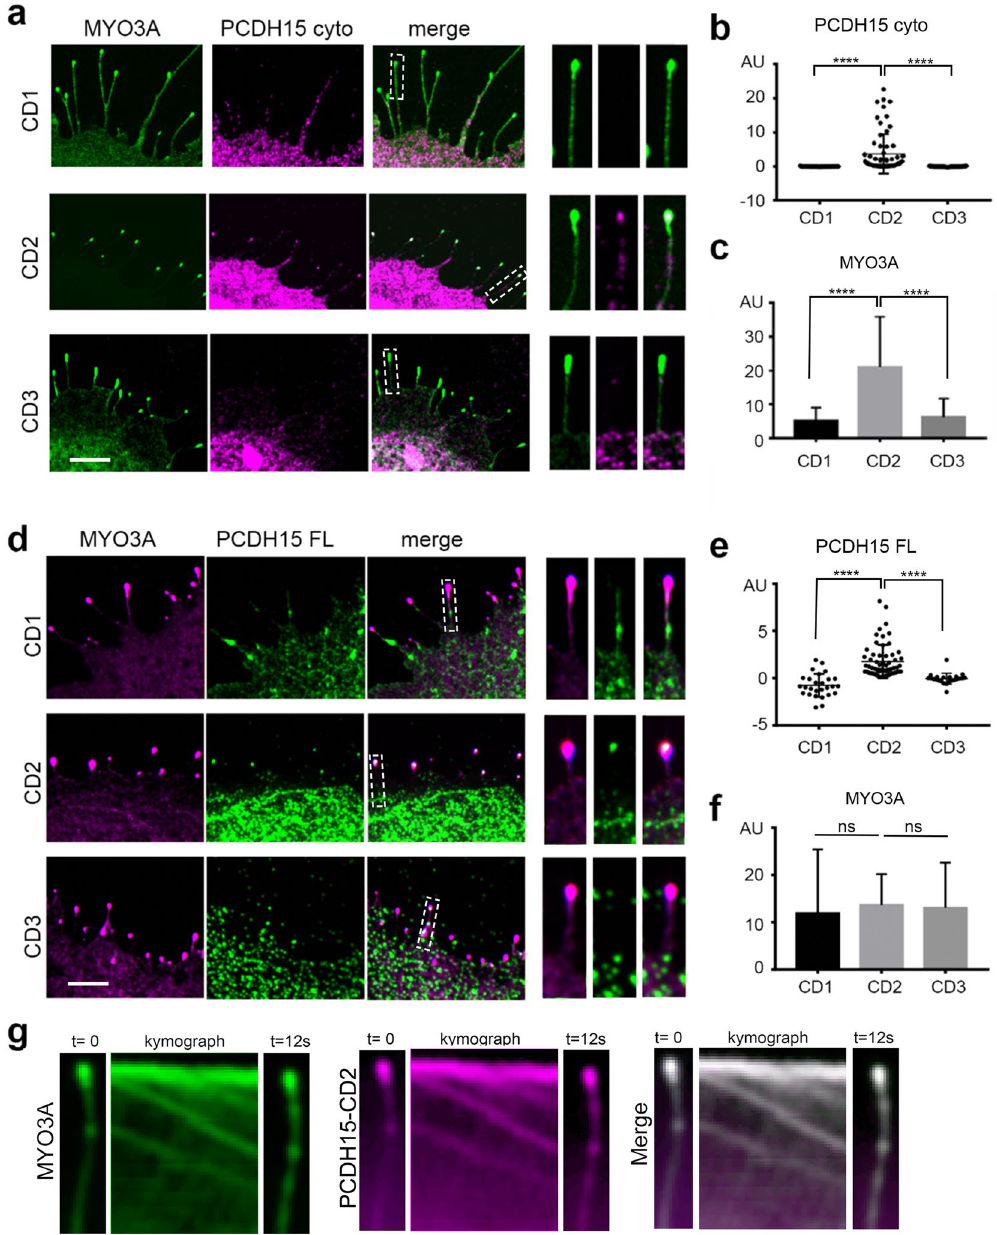
Figure 2. MYO3A actively transport PCDH15-CD2, but not CD1 or CD3, to the filopodia tips. ( a ) Confocal images of COS7 cells expressing GFP-MYO3A ΔK (green) and the cytoplasmic domain (cyto) of PCDH15-CD1, -CD2, or -CD3 (magenta). The right panels show a close-up view of a representative filopodia. ( b ) PCDH15-CD2 cyto exhibits significantly higher tip-to-shaft ratio than PCDH15-CD1 or PCDH15-CD3 when co-expressed with MYO3A. ( c ) Expression of PCDH15-CD2 enhanced the MYO3A enrichment at the filopodia tips (filopodia tip/shaft ratio). ( d ) Confocal images of COS7 cells expressing GFP-MYO3A ΔK (magenta) and Full-length PCDH15-CD1, -CD2, or -CD3 (green). ( e ) Full length PCDH15-CD2 exhibits significantly higher tip-to-shaft ratio than PCDH15-CD1 or PCDH15-CD3 when co-expressed with MYO3A. ( f ) MYO3A exhibit a similar enrichment at the filopodia tips when co-transfected with FL PCDH15-CD1, -CD2 or -CD3. Each dot in b and e represents one filopodia. Number of filopodia n = 23–66. One-way ANOVA analysis was performed with Dunnett’s multiple comparisons test. Level of significance was determined based on the p value (n.s p > 0.05, *p < 0.05, **p < 0.01, ***p < 0.001, ****p < 0.0001). ( g ) Kymographs depicting active transport of MYO3A and PCDH15-CD2 along a representative filopodium. Time elapsed from the first frame to the last was 12 s. The green and magenta fluorescence puncta correspond to clusters of MYO3A and PCDH15-CD2 co-translocating along the filipodium. Scale bars = 2